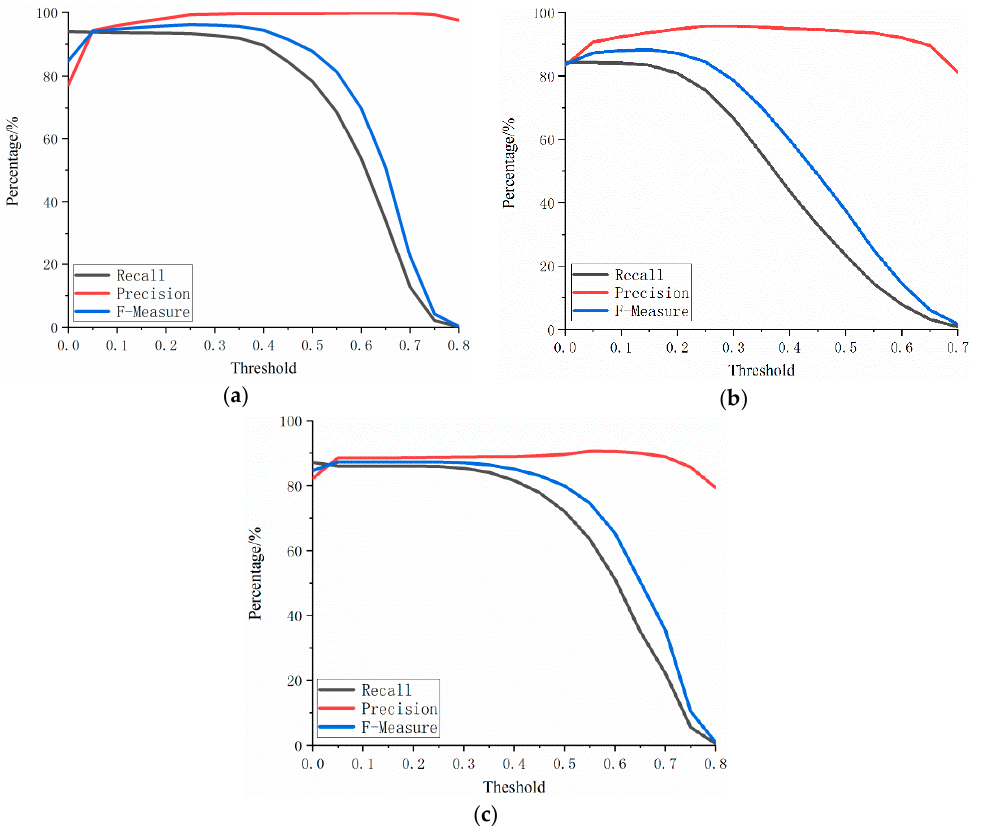
Figure 4. Precision analysis of threshold selection of the degree of overlap in raft aquaculture areas: degree of edge overlap in experimental result of study areas ( a ) 1, ( b ) 2, and ( c ) 3.